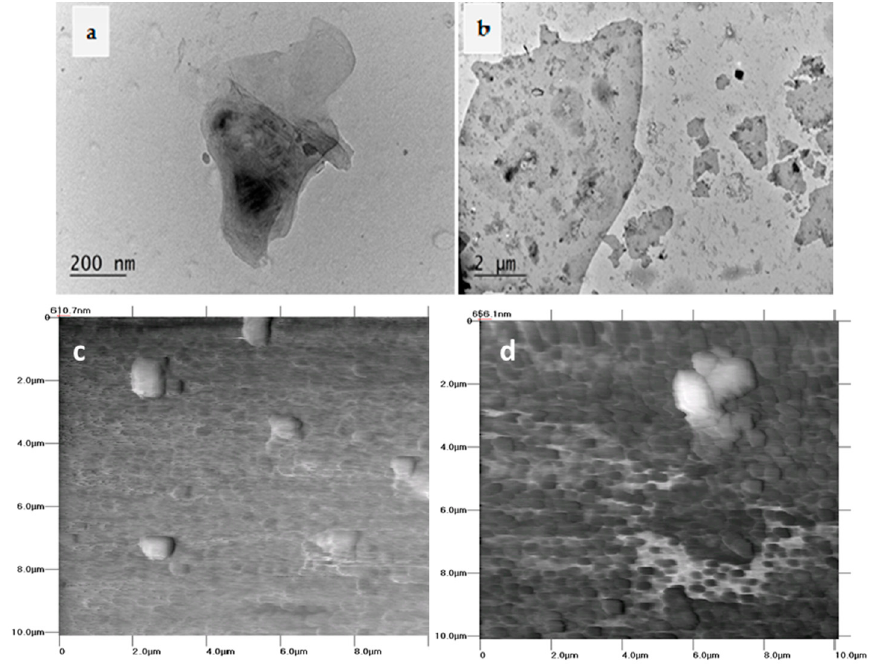
Figure 1. ( a , b ) transmission electron microscopy (TEM) micrographs and ( c , d ) atomic force microscopy (AFM) scan of dried migrants from GNP/MWCNT/PLA film after the ultra-strong dynamic test in 10% ethanol (first column) and 50% ethanol (second column).